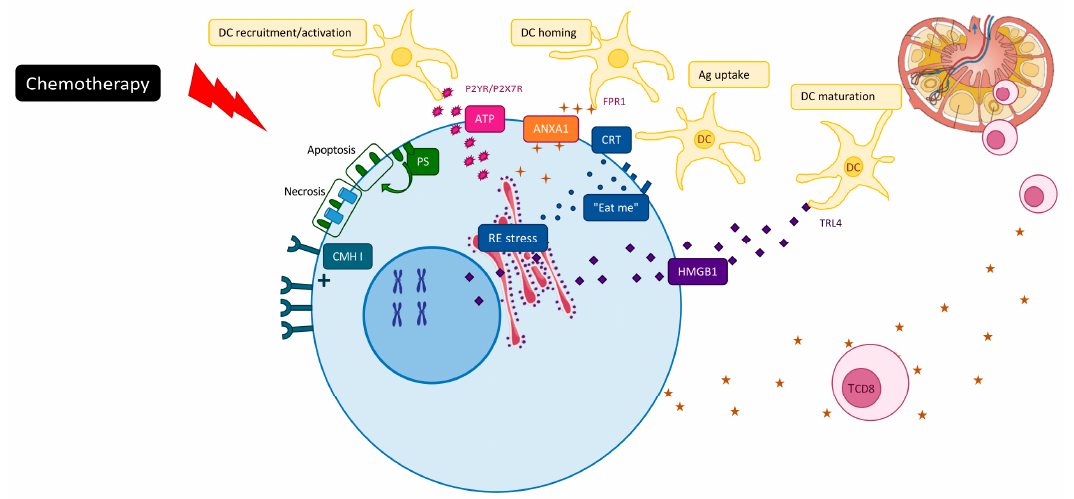
Figure 1. Mechanisms of chemotherapy-driven “immunogenic” cancer cell death (ICD).